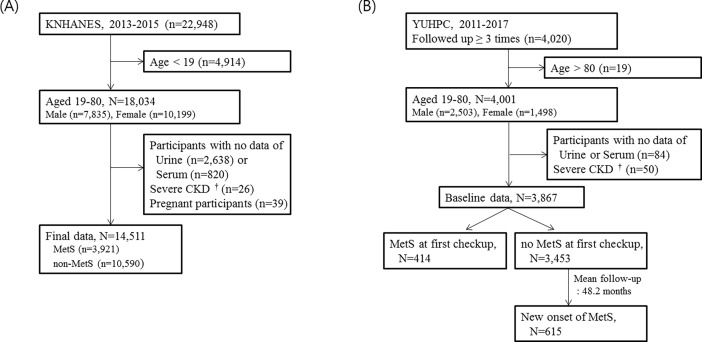
Description of study population.(A) Cross-sectional study based on KNHANES 2013–2015 and (B) retrospective longitudinal cohort study based on YUHPC. †estimated glomerular filtration rate < 30 ml/min/1.73 m2.